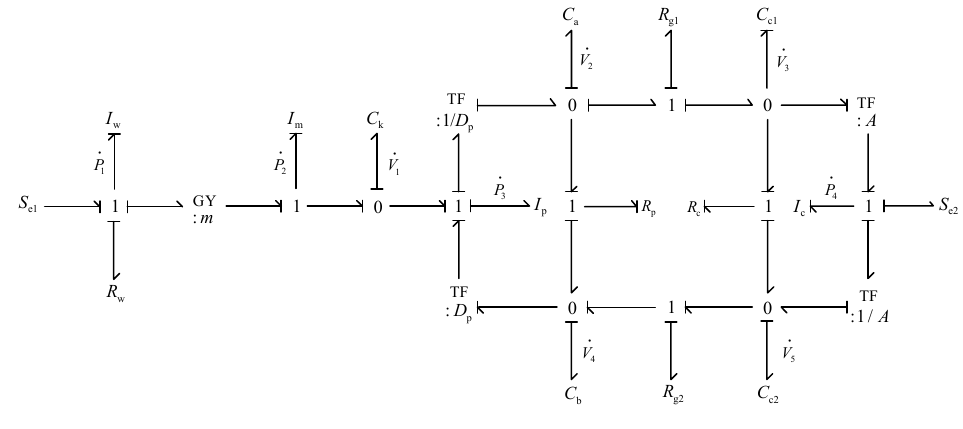
Figure 5. EHSPCS power bond graph model.